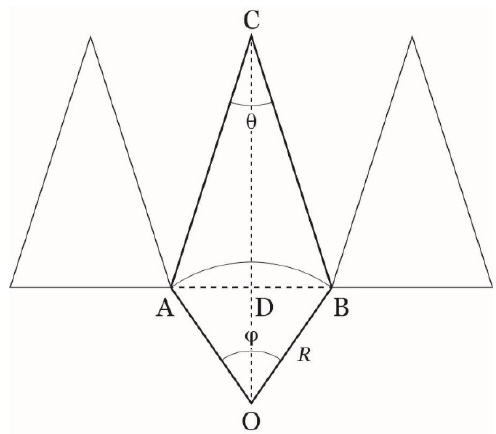
Figure 1. Geometry for finding the relationship between the geocentric angle ϕ and aperture angle θ (the main antenna lobe, e.g., at − 3 dB gain) of the downlink and uplink antennas of the GeoSurf. This situation, with no overlapping of the service areas, is found only at the equator. O is the center of the Earth; AB is the approximate diameter of the service area. R is the Earth radius, the segment CD gives the (approximate) height h of the orbit from the surface. The connected satellite is at C. The triangles at left and right give the position and service area of the adjacent satellites in the same orbit plane in the North − South direction, or in adjacent orbit planes in West − East direction but only at the equator (no overlapping).